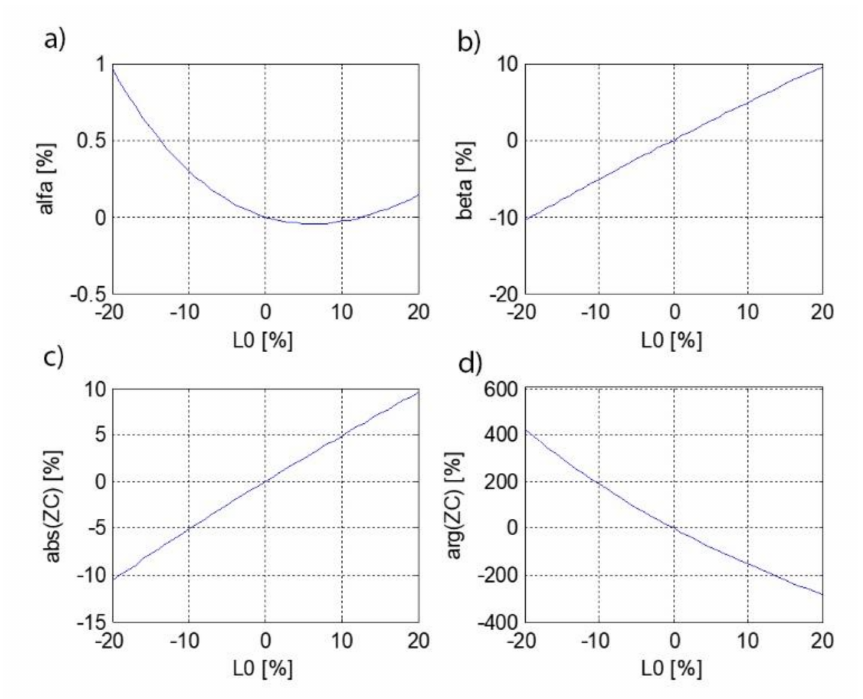
Figure 7. Changes of wave parameters depending on L 0 at f = 1 MHz; ( a ) damping factor α , ( b ) phase factor β , ( c ) wave impedance modulus, and ( d ) wave impedance argument.